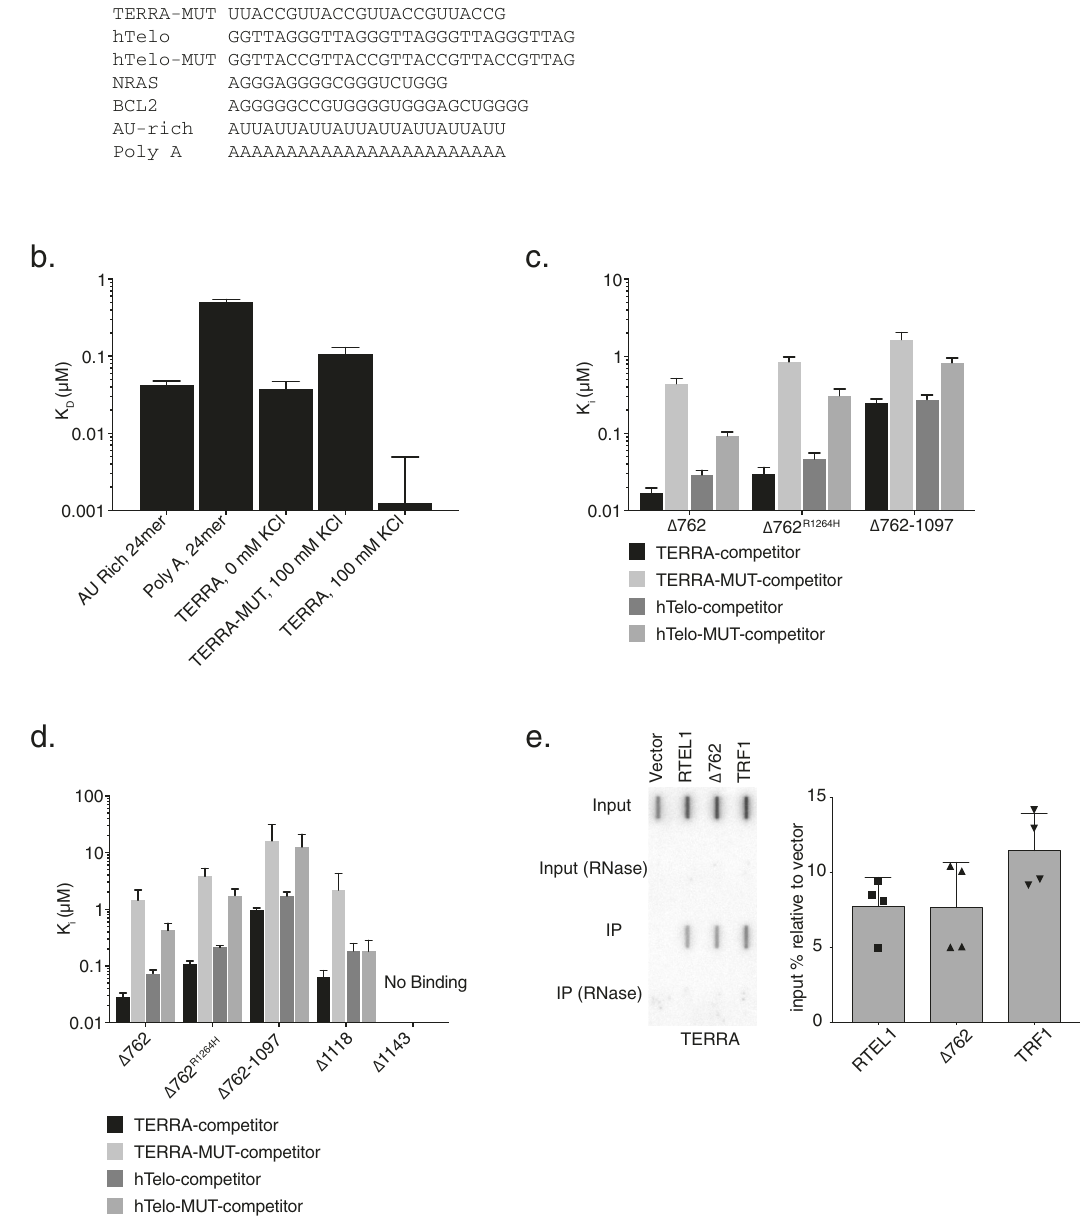
Fig. 2 The RTEL1 C-terminal Domain Binds TERRA and other G-quadruplex Structures. a Sequences of DNA and RNA substrates used in this study. b Nucleic acid binding of RTEL1 proteins lacking the helicase domains was monitored by fl uorescence anisotropy. Bar graph shows dissociation constants ( K D ) for TERRA and TERRA-MUT RNAs folded in the presence and absence of KCl and, AU-rich, and polyA RNA controls. c Increasing concentrations of the indicated oligonucleotides were added to reactions containing RTEL1 proteins and a 24mer FAM-TERRA-MUT RNA at 200 nM. Bar graphs depict apparent dissociation constants ( K i ) derived by competition of the bound FAM-TERRA-MUT by the indicated oligonucleotides using fl uorescence anisotropy. d K i ’ s of the indicated RTEL1 deletion constructs were derived by competition studies of FAM-TERRA-MUT and indicated RTEL1 proteins at 1 µ M as in panel C. No binding signal was observed for the RTEL1 Δ 1143 protein. All binding assays were conducted in triplicate, mean and standard deviation are shown. e RNA IP assays were done in HEK293T cells transfected with FLAG-tagged RTEL1, Δ 762, TRF1 or vector only control. Precipitated nucleic acids were treated with DNAse I for 1 h at 37 °C. IP RNA was analyzed by slot blotting and detected by autoradiography using a telomeric probe. Quantitation of four independent experiments with the mean and standard deviation of relative RNA-IP normalized to the vector only control is shown. Five percent of the input is shown in the top two rows. RNAse treatment is indicated (see also Supplementary Figs. 2 – The precipitated nucleic acids were treated in vitro with DNAseI, nucleic acids were slot blotted, probed for telomere repeats and and RNAseA (where indicated). The signal was abolished upon other RNAs then visualized by autoradiography (Fig. 2e and pre treatment with RNAseA but resistant to DNAseI treatment Supplementary Fig. 7B). Expression levels of the immunopreci- con fi rming the speci fi city for RNA in this assay. The pretreated pitated proteins are shown in (Supplementary Fig. 7A).